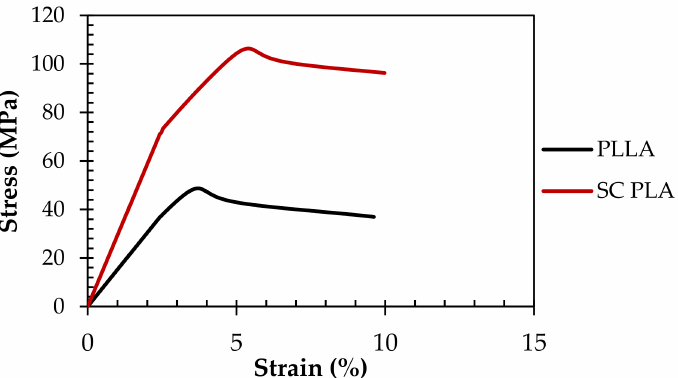
Figure 11. The tensile stress–strain curves of injection molded samples of neat PLLA (L175) and stereocomplex PLA.